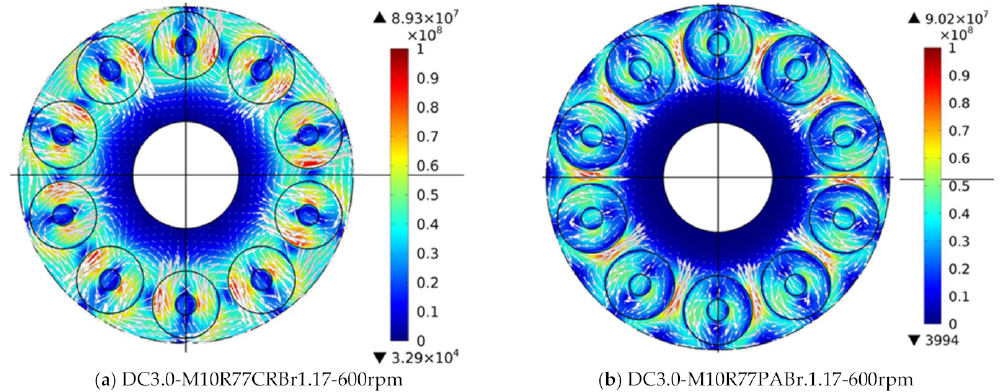
Figure 7. Distribution of current density [A/m 2